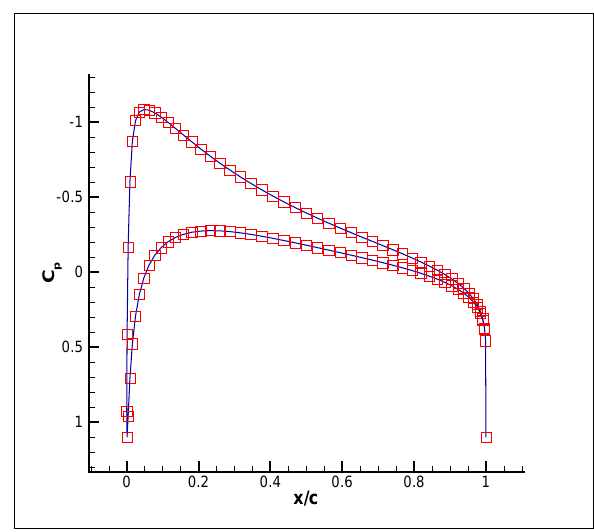
x/c Figure 14. The pressure coe ffi cient distribution for NACA0012 using FOILcom ( M ∞ = 0.63, α = 2 ◦ ).